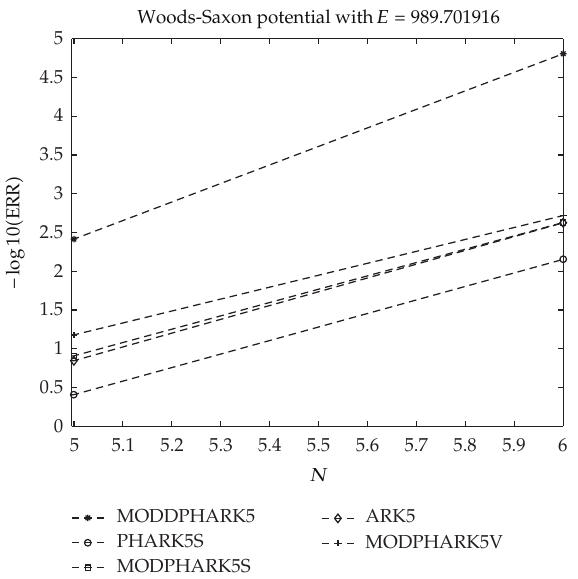
Figure 4: E ffi ciency curves for E (cid:7) 989 .